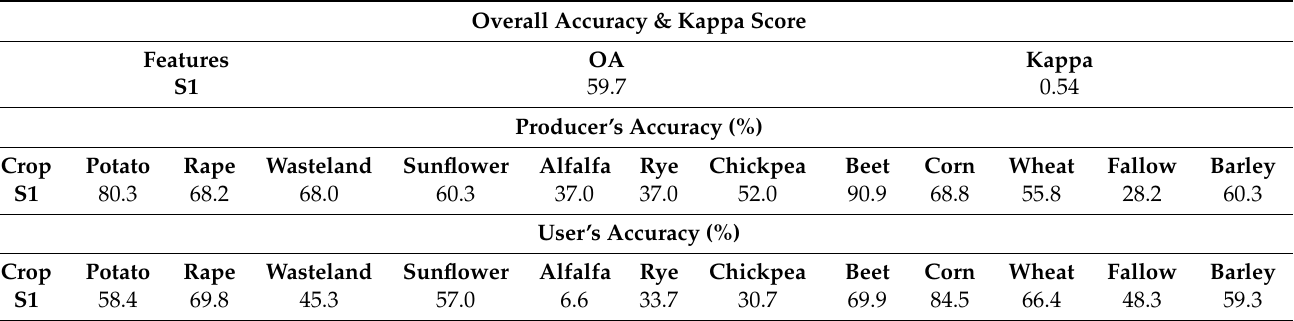
Table 4. Classification scores at pixel level with eight Sentinel-1